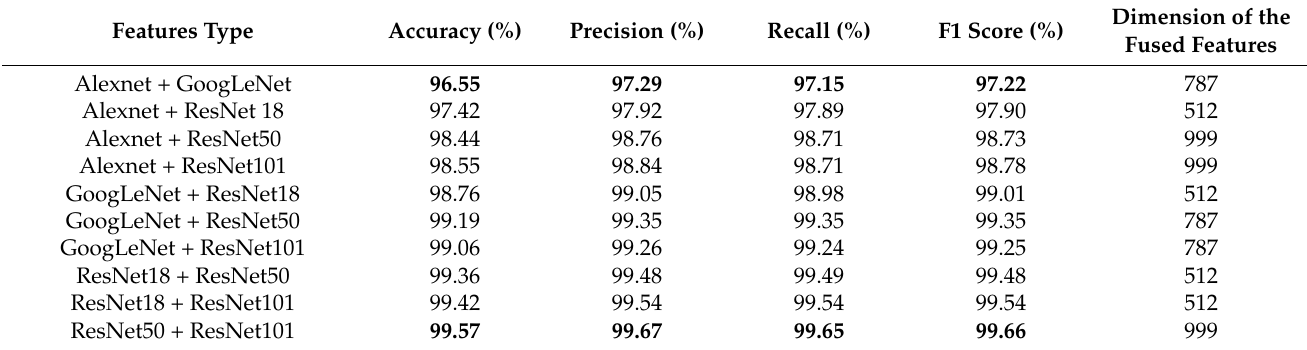
Table 6. Results of CCA sum fusion method (bold font shows the best